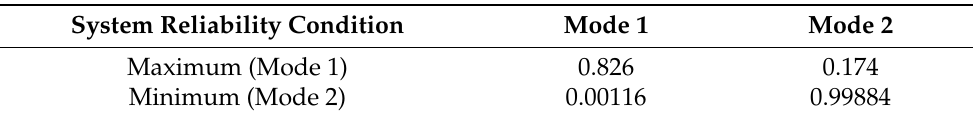
Table 5. Transition rate matrix.